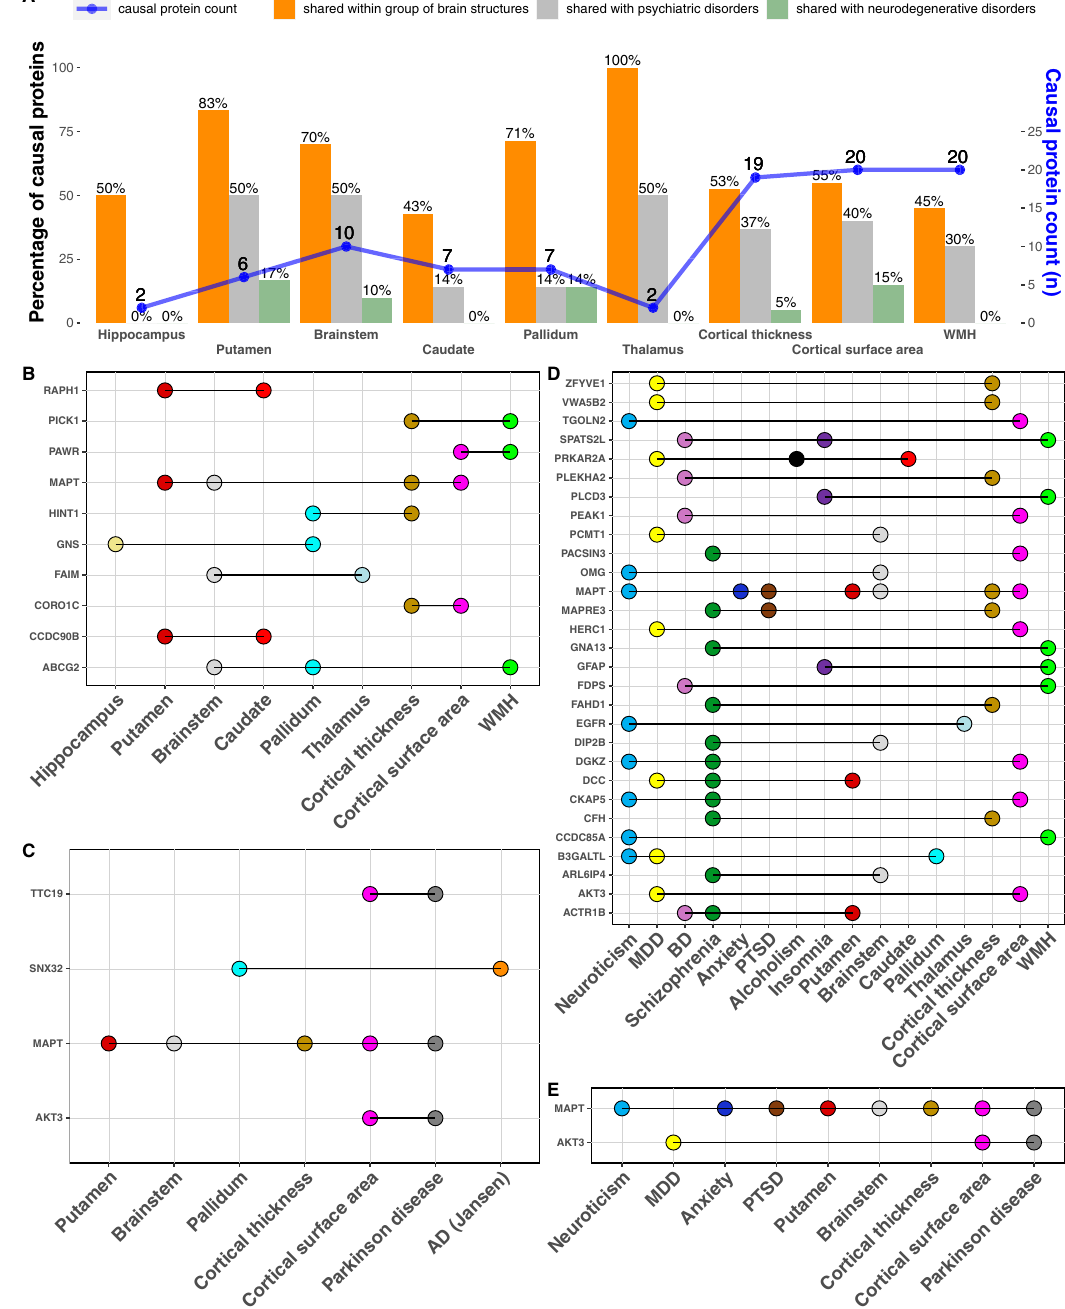
Fig. 4 | Causal proteins shared within the brain structure traits and shared between the brain structure group, the psychiatric group, and neurodegen- erative group, respectively. A Number of causal proteins and percent shared within the brain structure group and between the brain structure group and the